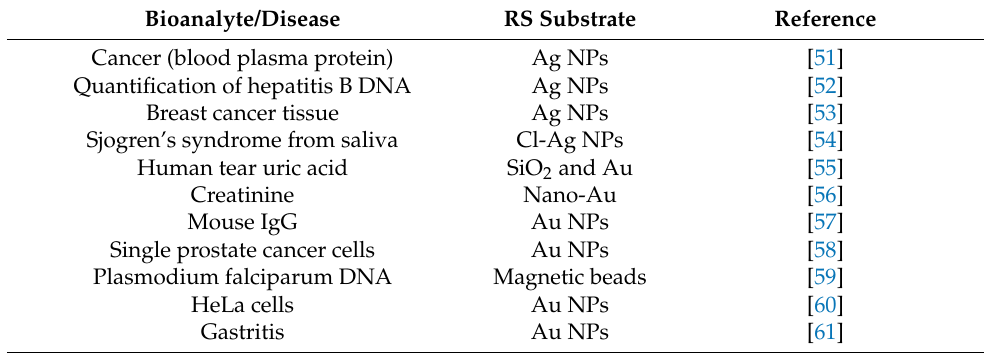
Table 2. Bioanalytes/diseases detected using